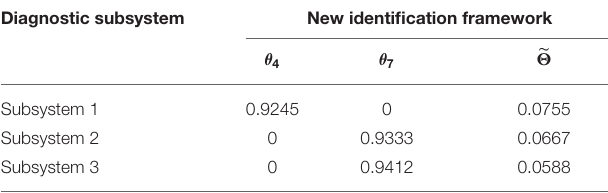
TABLE 4 | Identification framework after refinement and coarsening.